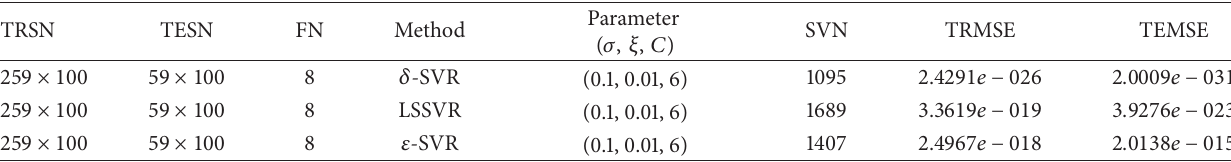
Table 1: Result of comparative